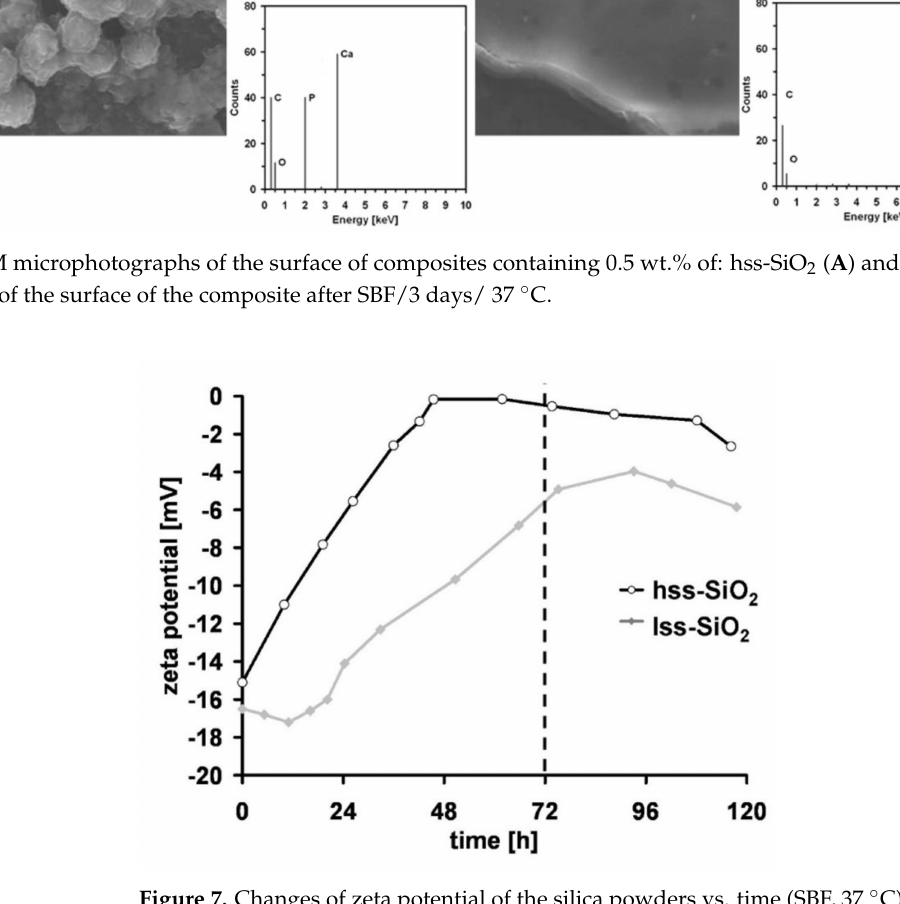
Figure 7. Changes of zeta potential of the silica powders vs. time (SBF, 37 ◦